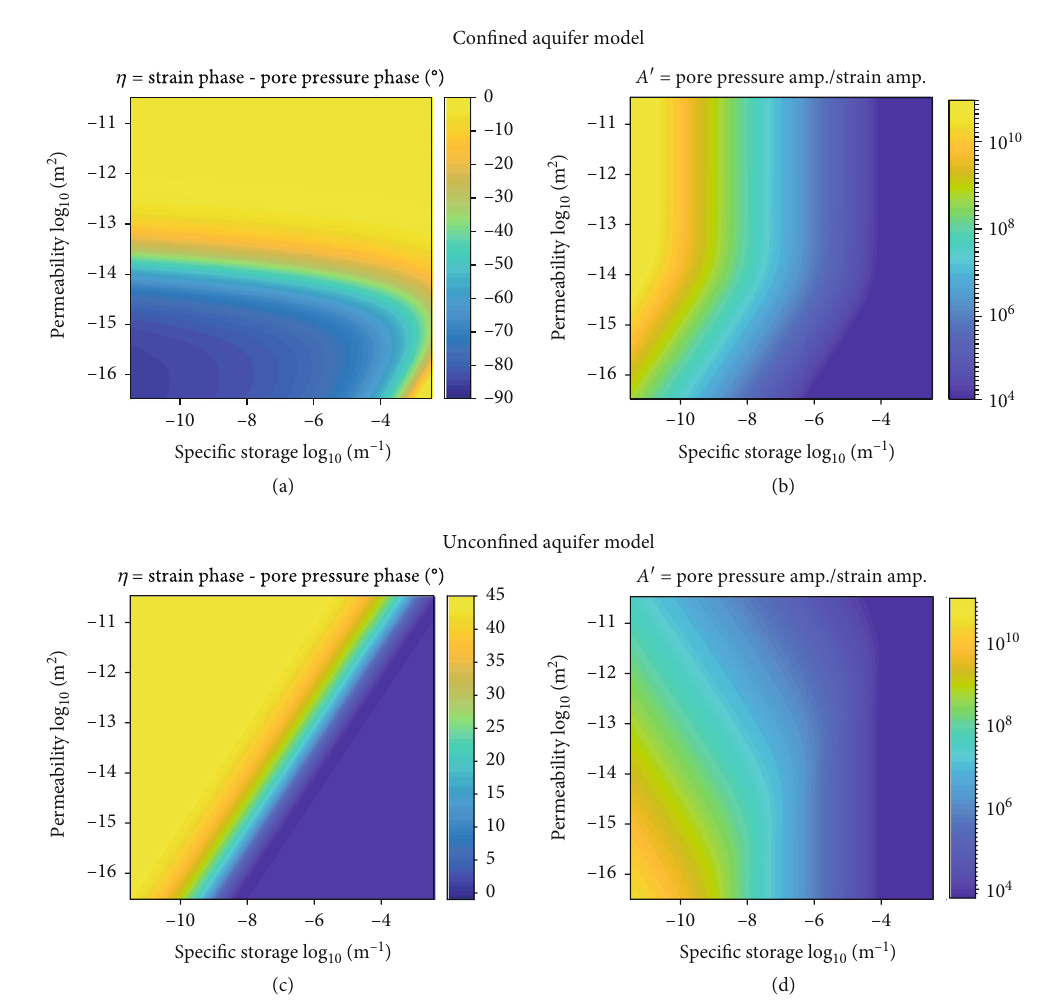
Figure 2: Color map of phase lag and amplitude ratio solutions for con fi ned (a, b) and uncon fi ned (c, d) aquifer fl ow solutions considering the borehole parameters corresponding to borehole B001.